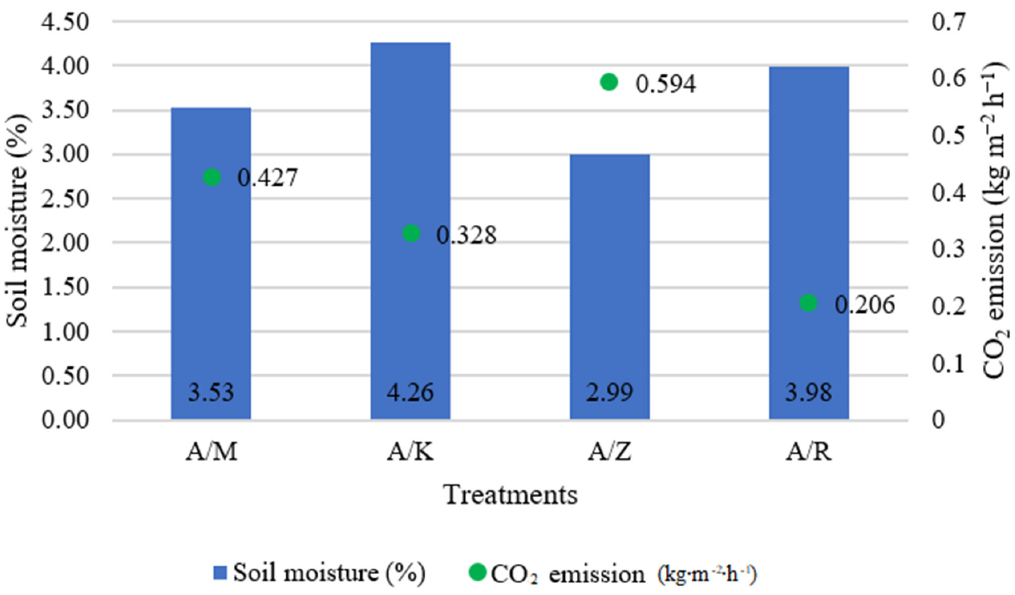
Figure 4. Average results of soil moisture (%), CO 2 -emission (kg m − 2 · h − 1 ) by treatment on 11 September 2019 (Karcag). Note: A/Z: Unused/abandonment grassland treatment; A/M: mulch treatment; A/K: Mowing treatment; A/R: Grassland.